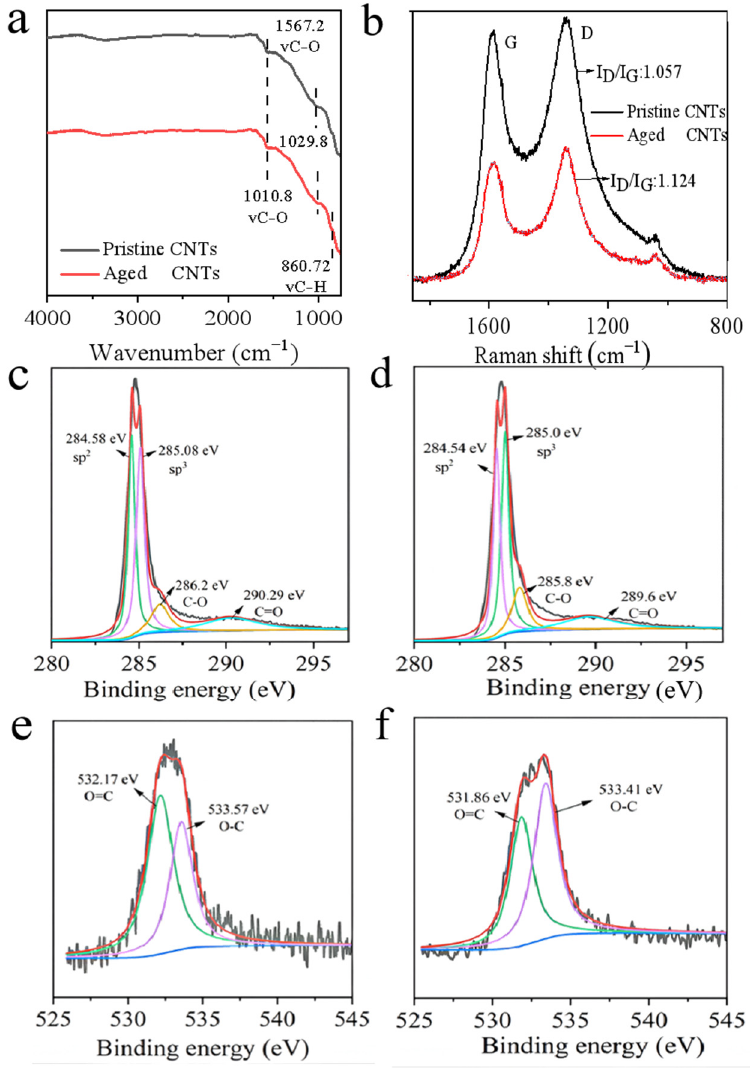
Figure 1. FTIR spectra ( a ) and Raman spectra ( b ) of pristine and aged CNTs; XPS spectra of pristine CNTs ( c , e ) and aged CNTs ( d , f ).